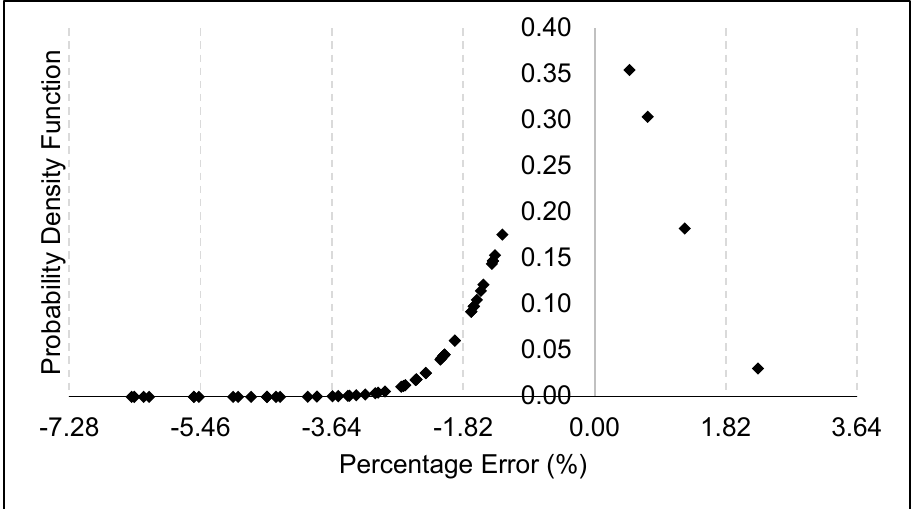
Figure 7. Validation results of the developed ANN against the FEM.